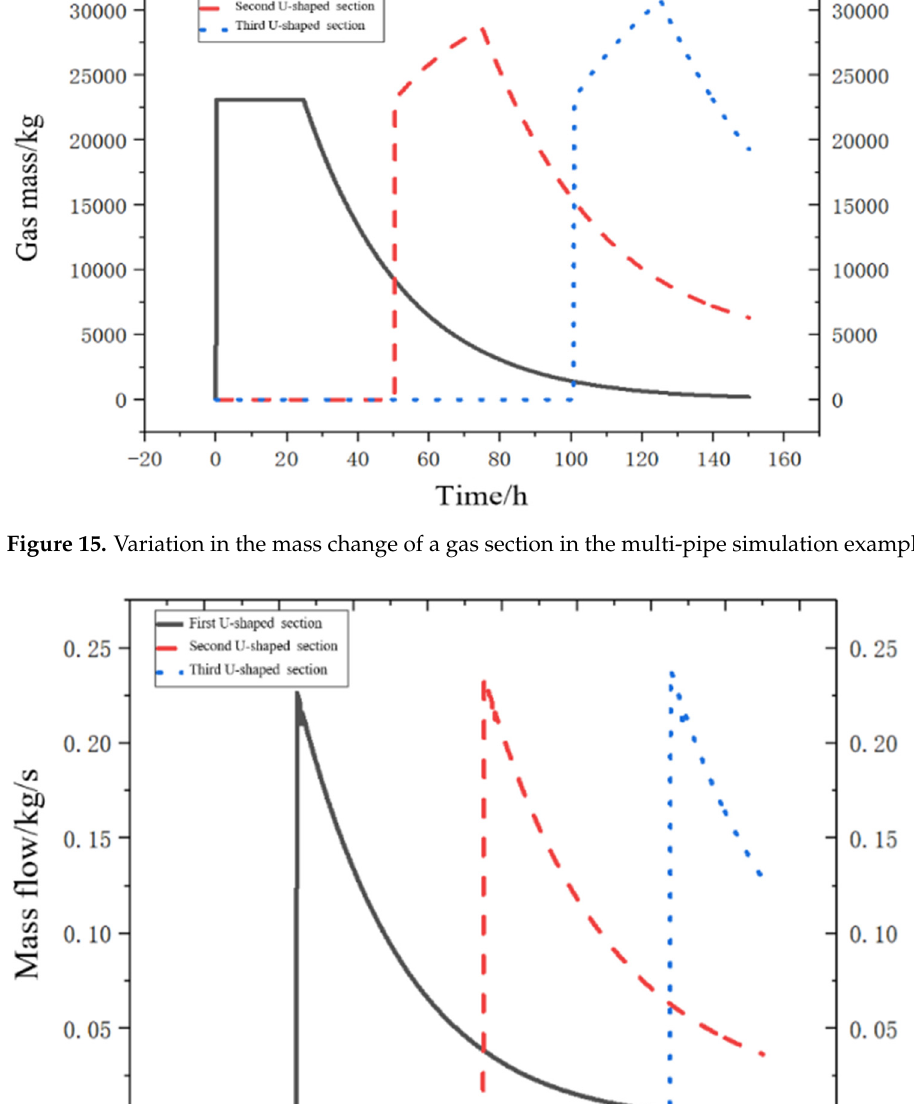
Figure 14. Variation in the pressure of a gas section in the multi-pipe simulation example.